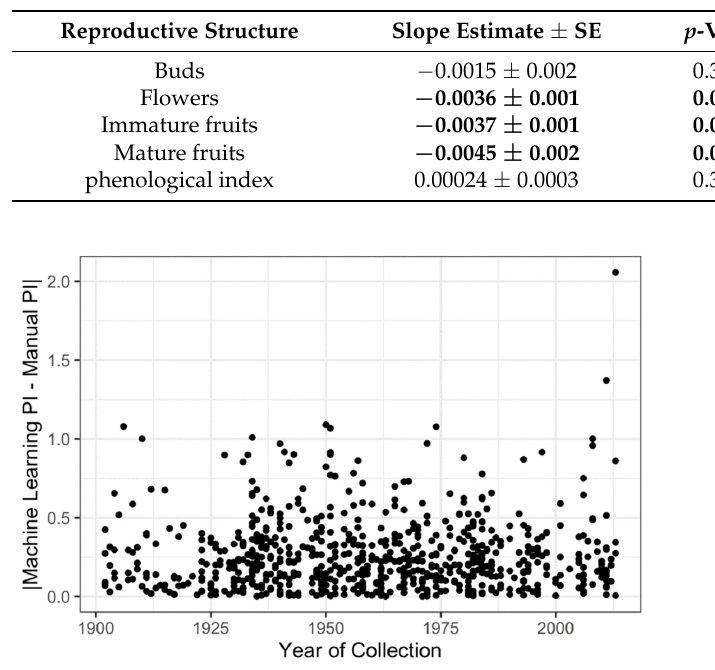
Figure 5. Bivariate plot showing the relationship between the year of specimen collection (i.e., specimen age) and the absolute difference between the machine-learning-derived estimate of the phenological index (PI) and the manually-derived (from human observers) estimate of the PI, or PI estimation error. There is no relationship between estimation error and the year of specimen collection.